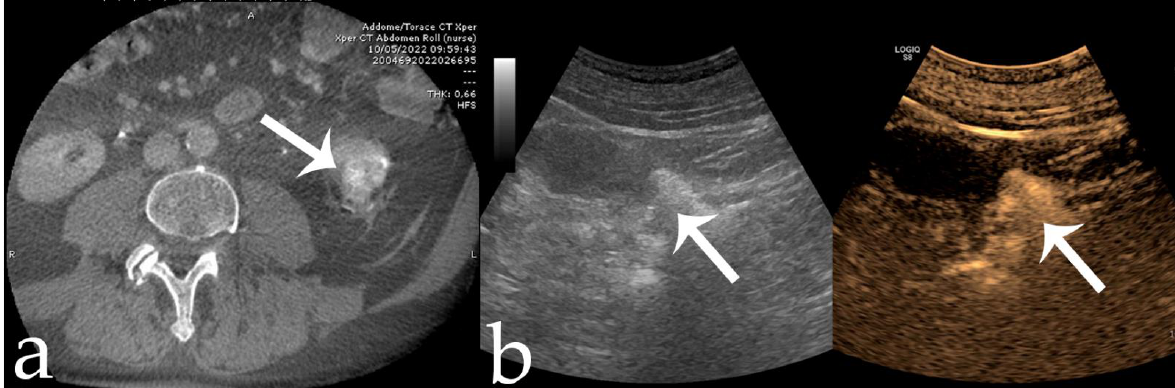
Figure 4. Same case as Figure 3. ( a , b ) Post-procedural CBCT and CEUS showing complete tumor devascularization (arrows).